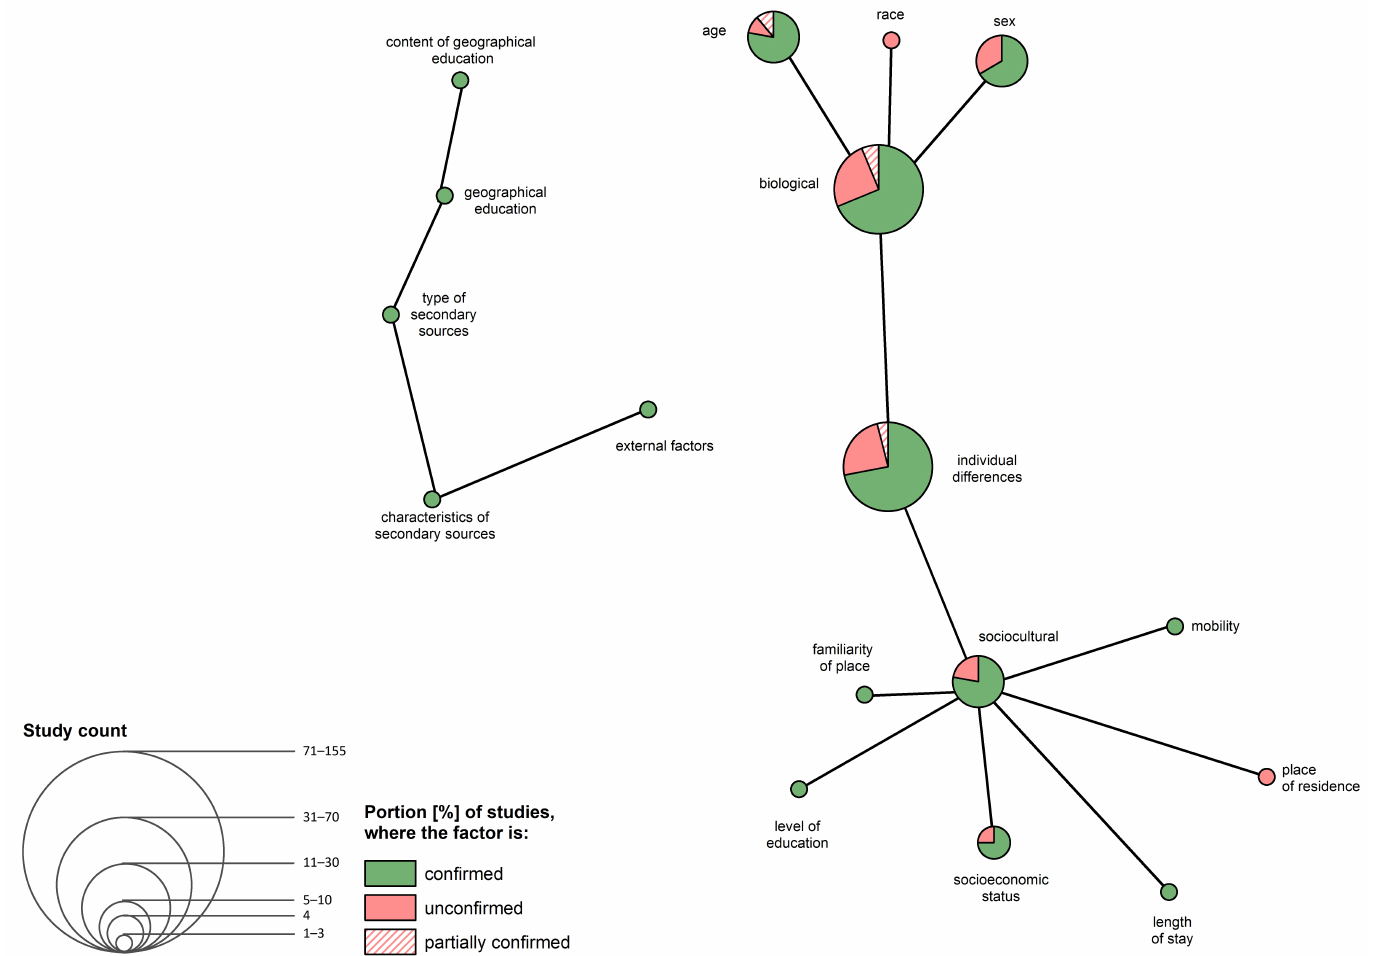
Figure 9. Factors influencing the choice of cartographic method for the creation of sketch